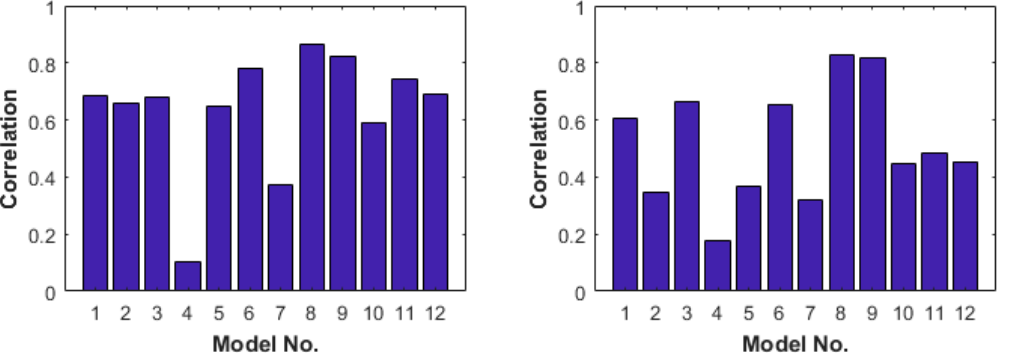
Figure 9. The correlation coefficients of the predicted CTEI values from all the 12 models with the best-fitted algorithm (model 8 with the SVM algorithm) for the training (left side) and the testing period.